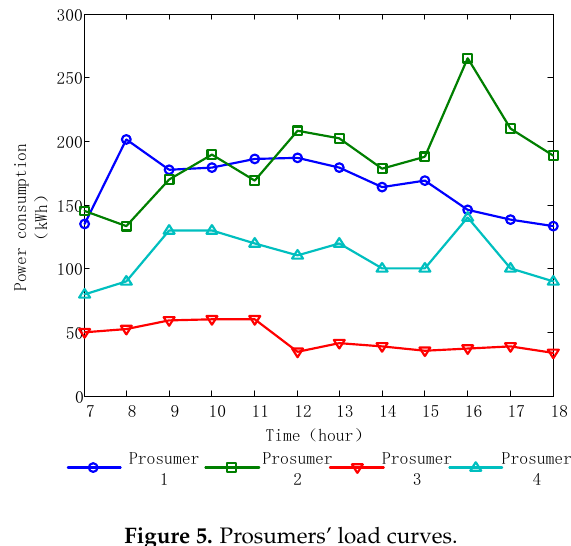
Energies 2016 , 9 , 536